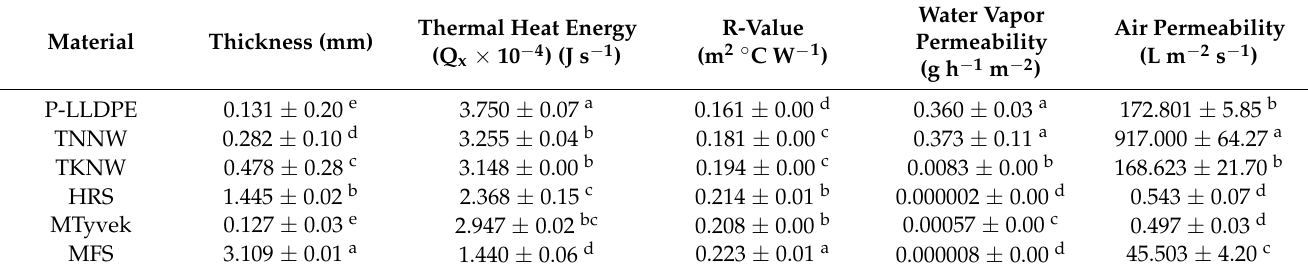
Table 2. The properties of six covering materials (thickness, thermal heat energy, WVP, R-value and air permeability).